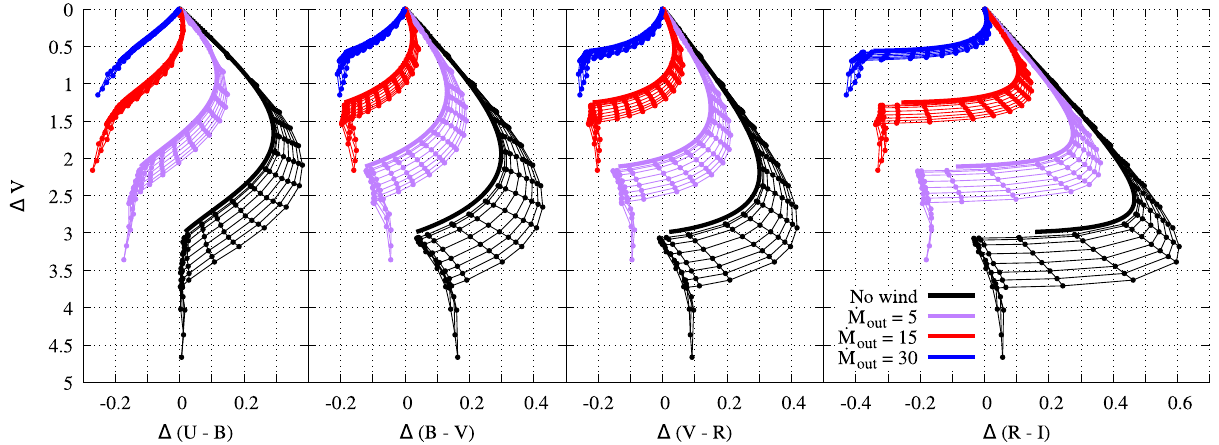
Figure 6: Changes in color indices during the disk perturbation eclipses for the same disk models as in Figure 3. The compact cloud eclipse results are shown with thick lines for